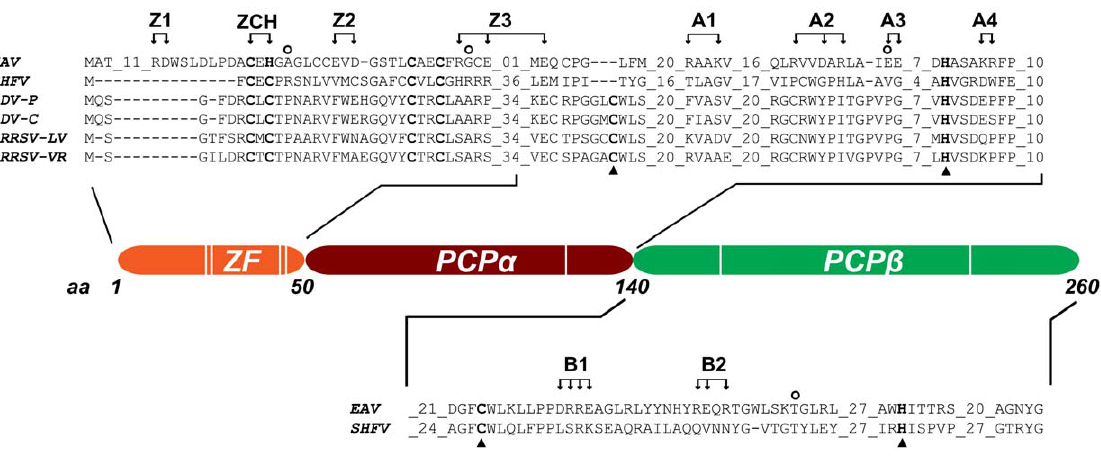
Figure 2. Domain organization of EAV nsp1. The partial sequence alignment shows key regions in the three subdomains previously identified in the arterivirus nsp1 region. GenBank accession numbers for the full-length arterivirus genomes used for the alignment are as follows: EAV, NC_002532; simian hemorrhagic fever virus (SHFV), NC_003092; lactate dehydrogenase-elevating virus (LDV-P and LDV-C), NC_001639 and NC_002534; PRRSV-LV, M96262.2; PRRSV-VR, AY150564. Zinc-coordinating residues are indicated in bold font; the active-site Cys and His of PCP a and PCP b are indicated with triangles (note the loss of the active-site Cys in EAV PCP a ). The positions of amino acid clusters mutated in this study are indicated with arrows. All substitutions were with Ala, with the exception of the ZCH construct, in which Cys-25 and His-27 were swapped. The positions of mutations found in pseudorevertants are indicated with open circles.